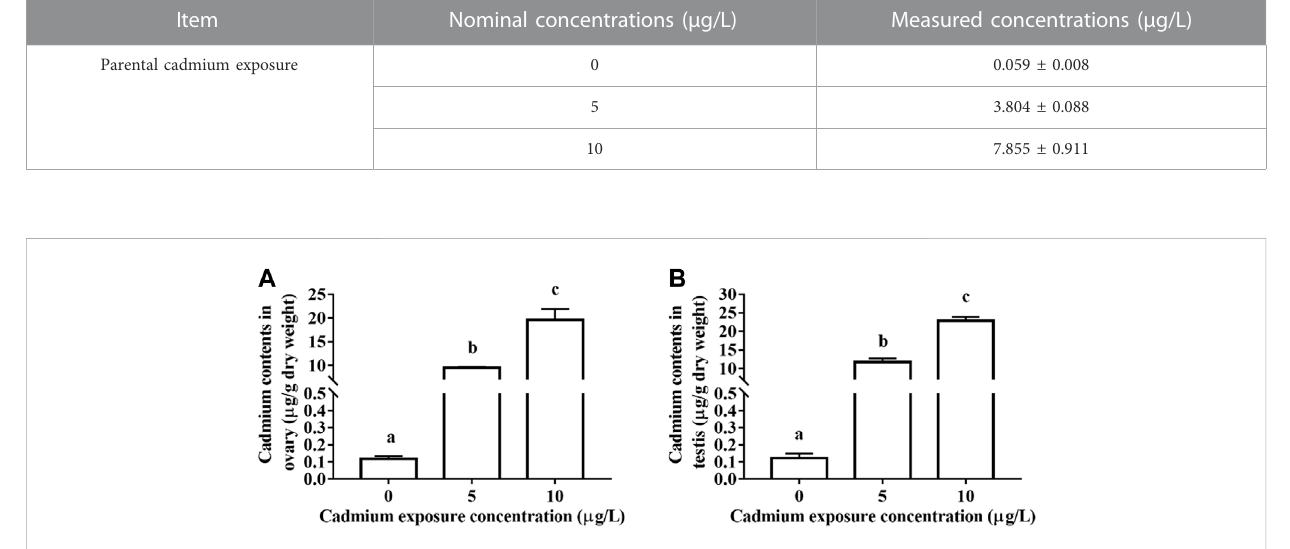
FIGURE 1 The contents of Cd in the ovary (A) and testis (B) of rare minnows (Gobiocypris rarus) exposed to 0, 5, and 10 μ g/L for 28 days.